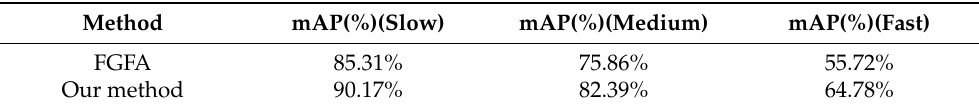
Table 4. Comparison between FGFA and the proposed